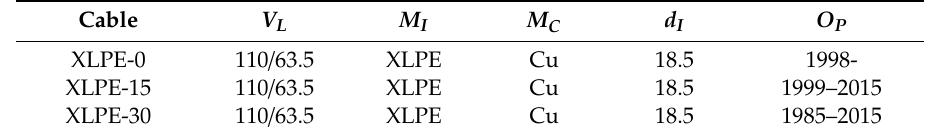
Table 1. Critical parameters of the cables.